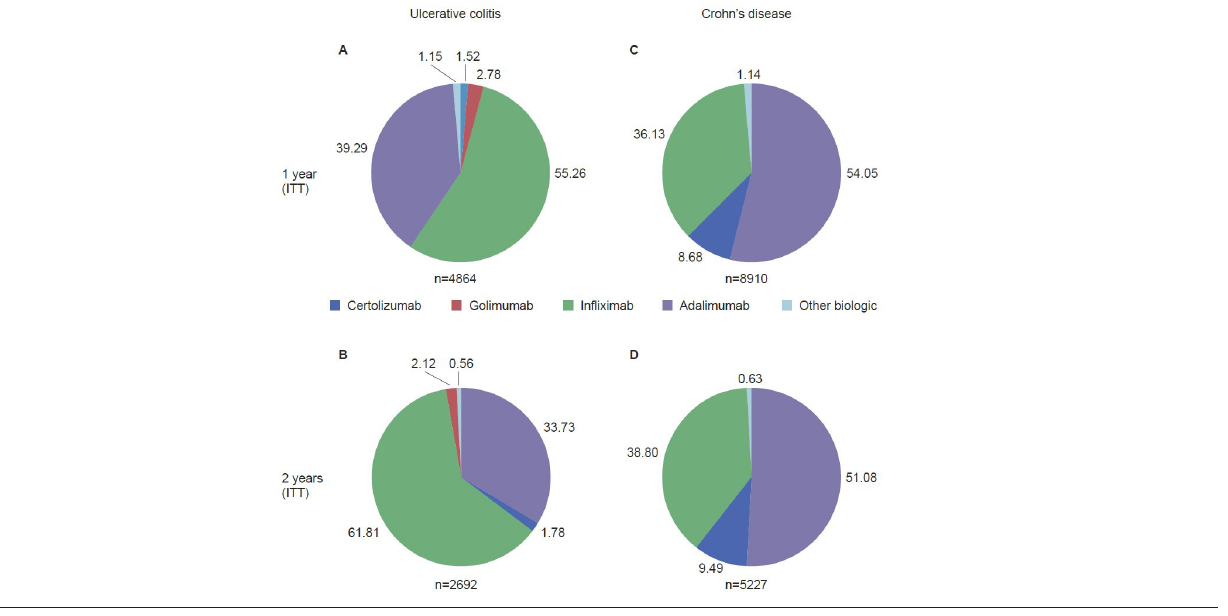
Biologics initiated in patients with UC (A and B) and CD (C and D) included in the 1-year (A and C) and 2-year (B and D) cohorts, irrespective of whether they continued to receive them or not during follow-up (ITT population). Values indicate percentage of patients.